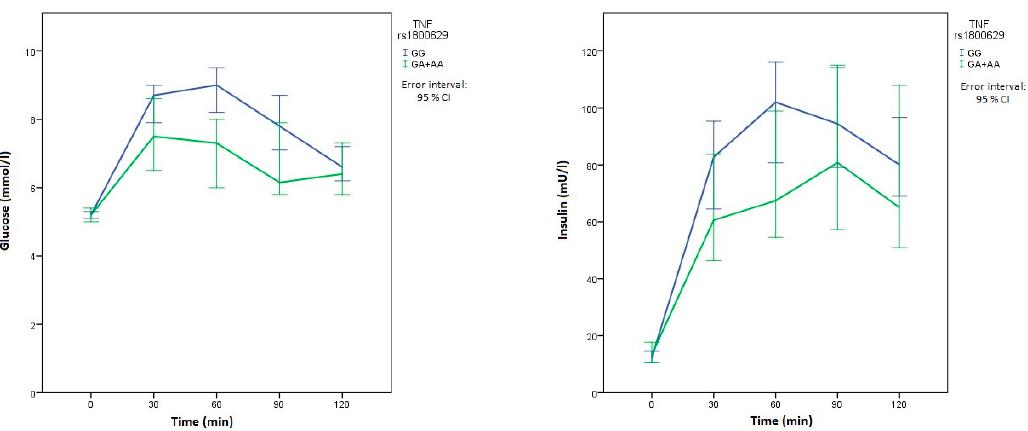
Figure 3. Time course of glucose and insulin concentrations for TNF rs1800629. The blue line represents the reference genotype, while the green line represents patients with at least one polymorphic allele.